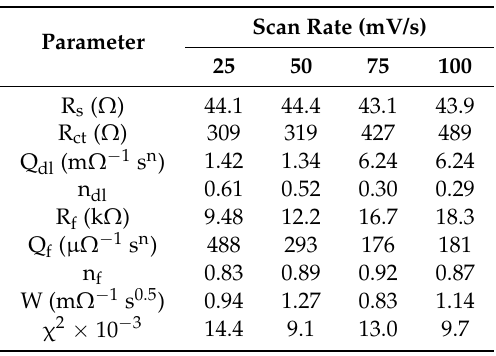
Table 3. Parameters obtained from electrochemical impedance spectroscopy data simulation for poly-(4-HPA)/GE platforms modified with different scan rates (mean, n =